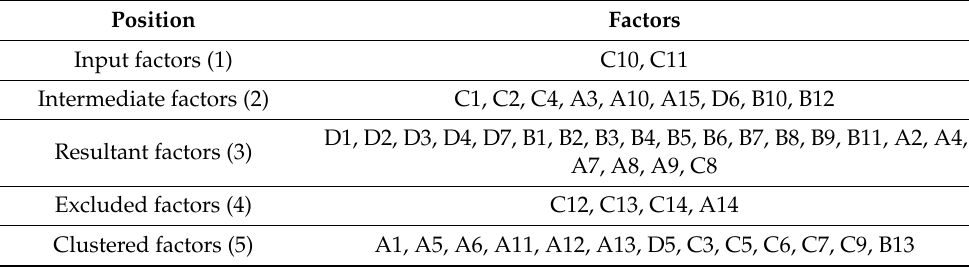
Figure 5. Weighted-out-degree. Table 5. The position of each factor in the influence-dependence